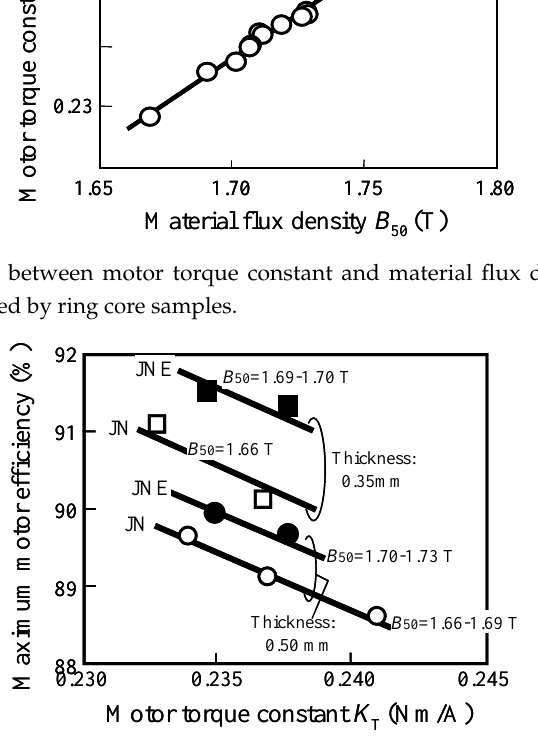
Figure 4. Relationship between torque constant and maximum efficiency in comparison of material flux density B 50 .